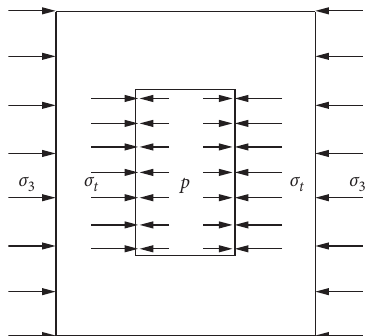
Figure 1: Mechanical model of the single-cracked rock under water pressure.